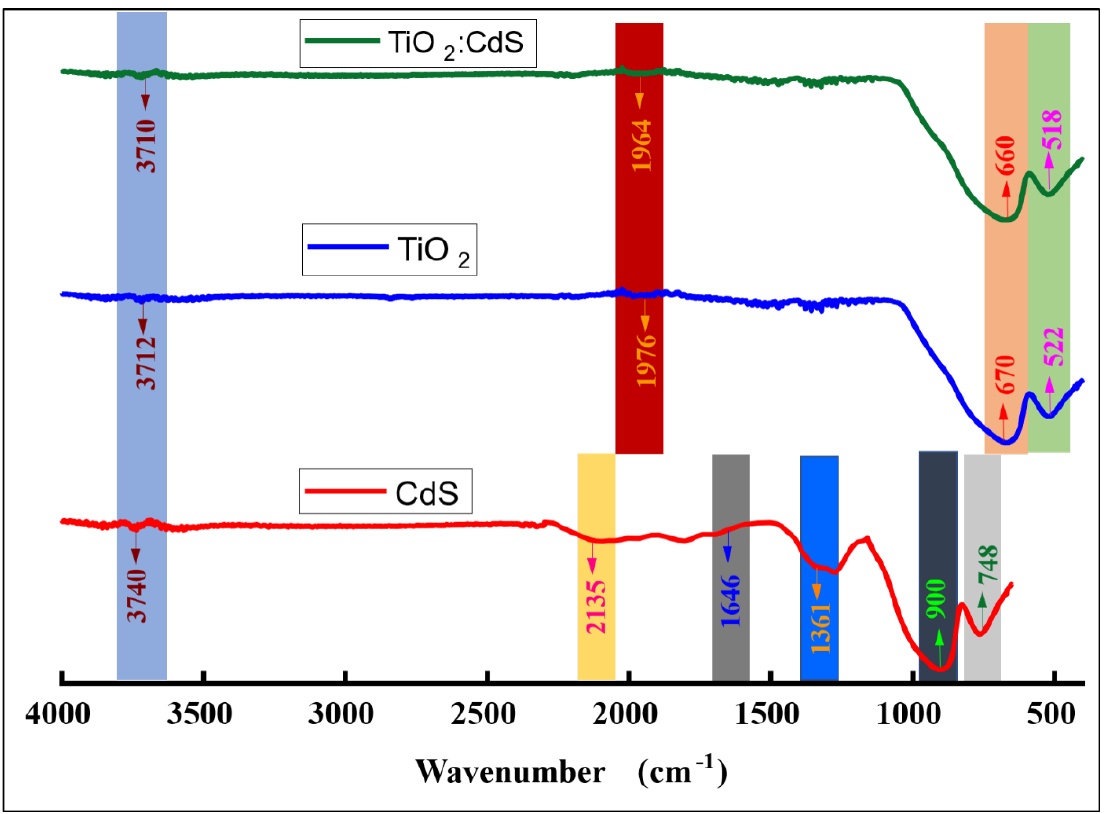
Figure 6. FTIR spectra for deposited thin films.